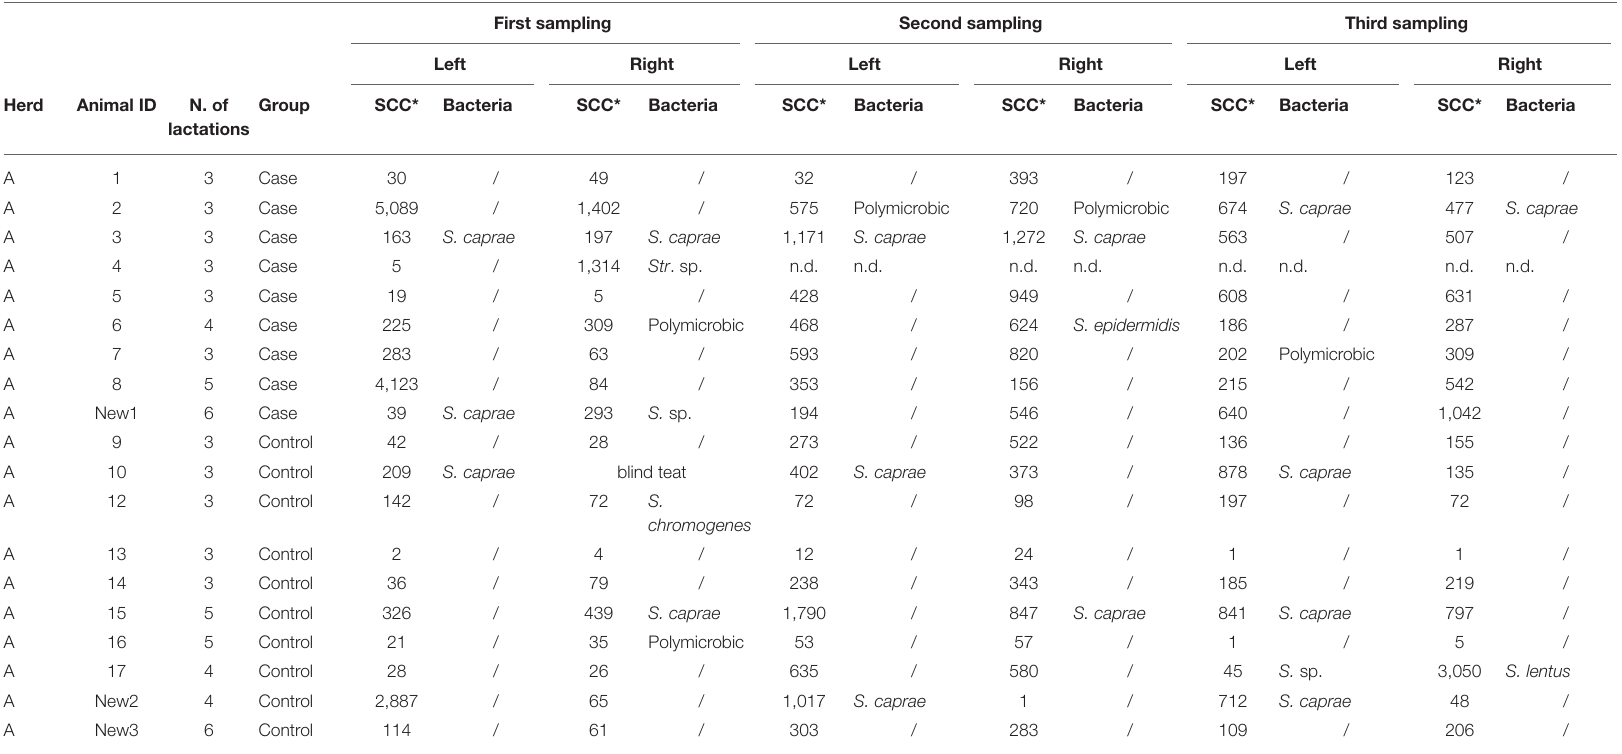
TABLE 4 | Results of bacteriological analysis and SCC determination on half-udder milk samples from 19 Alpine goats (9 cases and 10 controls) collected in herd A in 2019 at three timepoints (at the beginning, in the middle, and at the end of